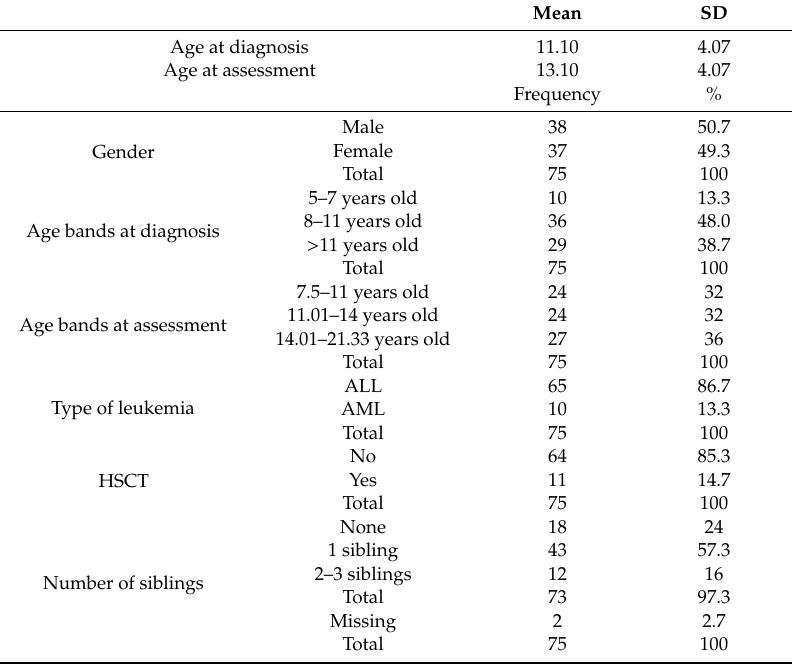
Table 1. Patients’ socio-demographic